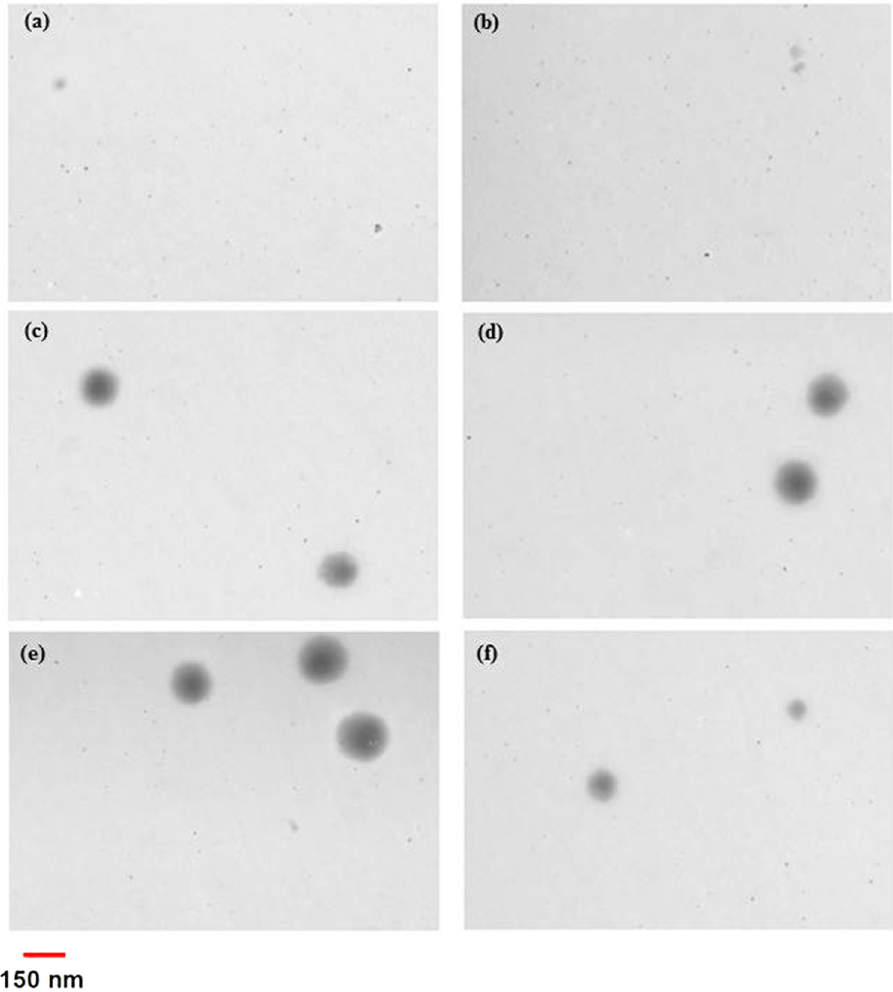
Figure 5: Morphological attributes ( size and shape ) of the prepared thyme nanoemulsions using Tween 80 ( a ) , Tween 20 ( b ) , saponin ( c ) , sodium caseinate ( d ) , Arabic gum ( e ) , and xanthan gum ( f )